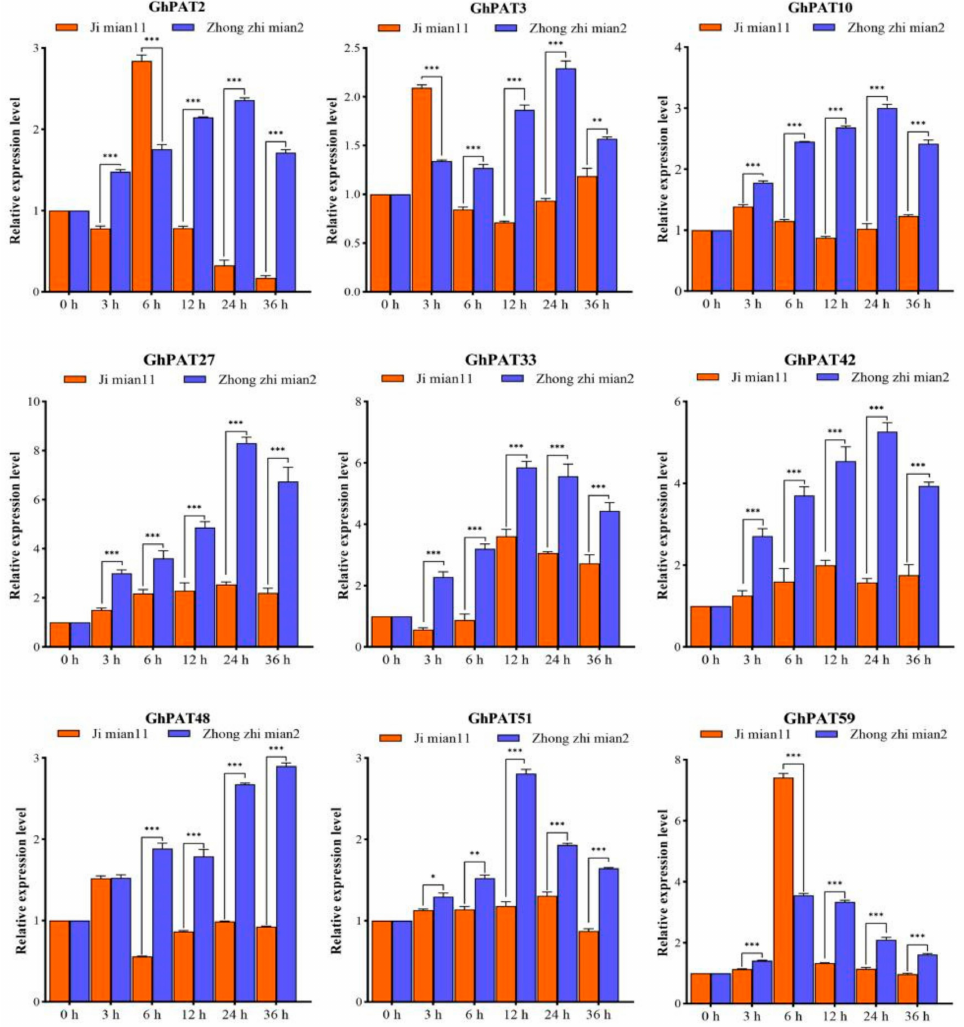
Figure 10. qRT-PCR of the response of GhPATs to V. dahliae . The relative expression of GhPAT27 was all calculated based on the control gene GhUBQ7 . Three technical replicates and three biological replicates were set up for each experiment. Statistically significant differences from the control group are indicated as * p < 0.05; ** p < 0.01; *** p < 0.001. As genes are represented differently in different locations in the plant, they perform different biological functions. To further characterize the function of the predicted gene GhPAT27 , different materials were inoculated with V. dahliae at different times, and tissue- specific expression assays were carried out. When a cotton plant is infected with V. dahliae , its root tissue is the first to be sensed, followed by the stem, and finally by the